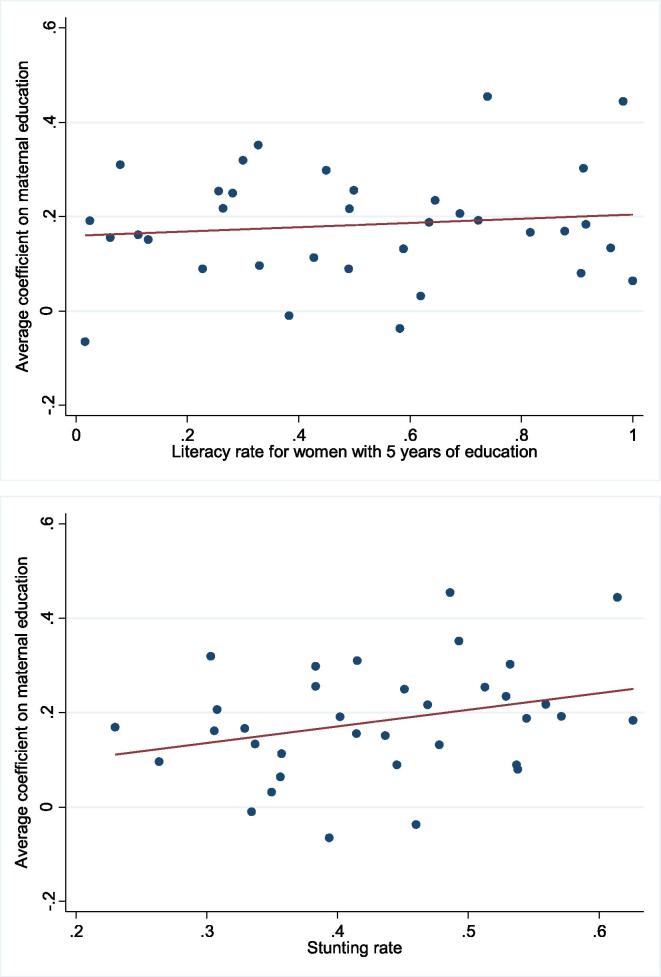
Country-level estimates of the average marginal impacts of maternal education on HAZ1 against stunting rates (Panel A) and grade 5 literacy rates (Panel B). Notes: Average coefficients refer to the average of coefficients for the 7–9, 10–12 and 13 + education brackets for maternal education.